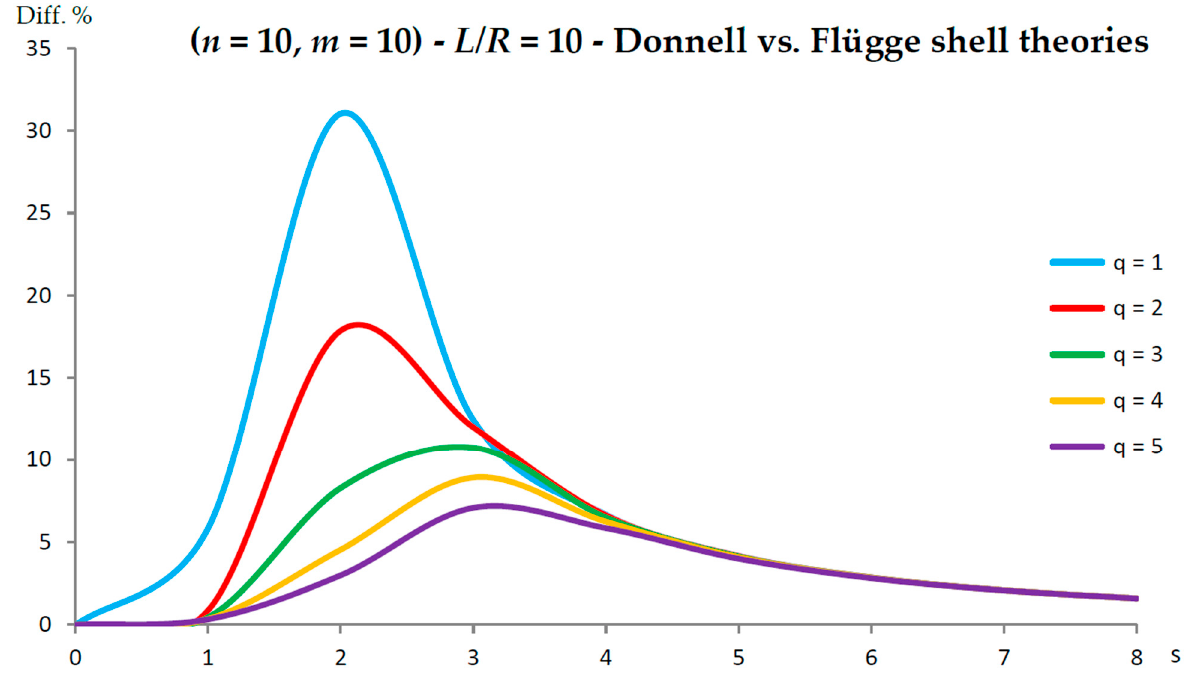
Figure 4. Percentage differences between the radial natural frequencies obtained via Donnell and Flügge shell theories (Flügge as the reference). Anisotropic elastic shell model. Simply supported SWCNT of Table 1 with chirality indices (𝑛 = 10, 𝑚 = 10) and aspect ratio 𝐿/𝑅 = 10 . Number of longitudinal half-waves 𝑞 . Number of circumferential waves 𝑠 .